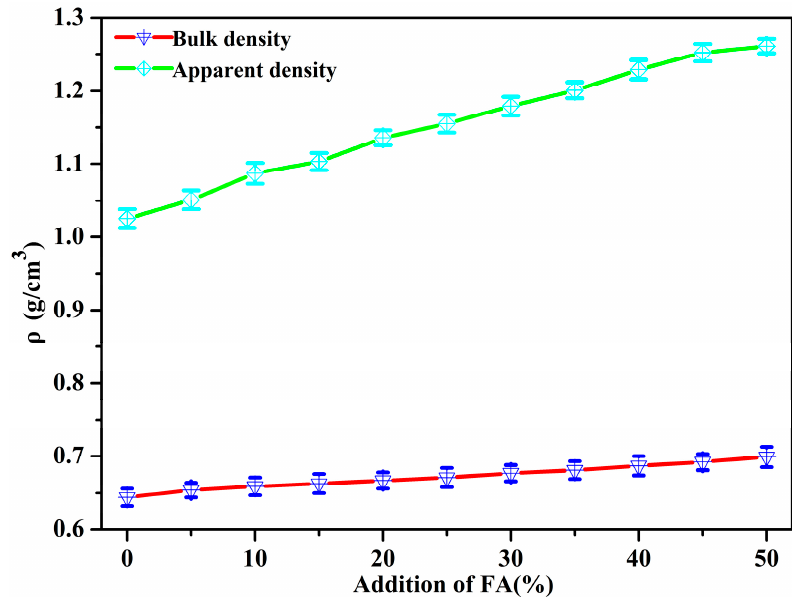
Figure 6. Apparent density and bulk density of poly(St- co -MMA)/FA microspheres.